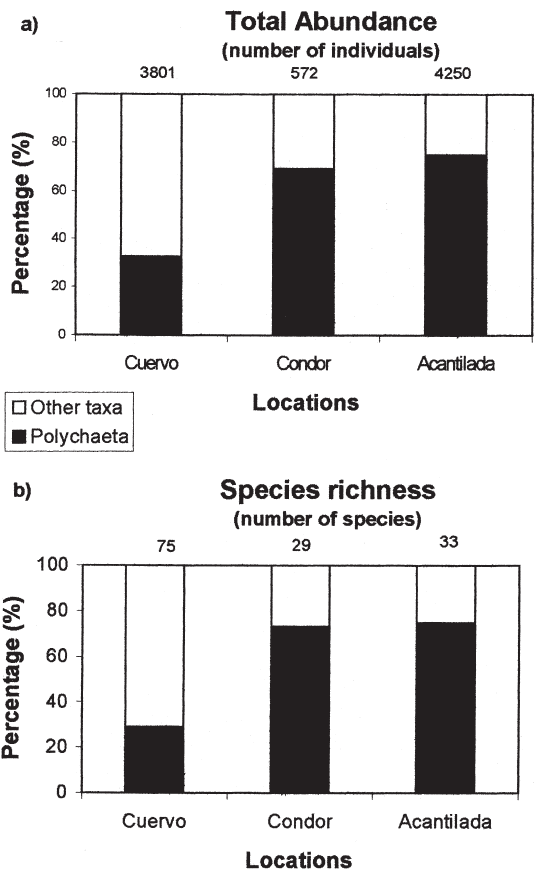
F IG . 3. – Comparison between Polychaeta and other invertebrate taxa collected in shallow, subtidal macrozoobenthos communities from three localities in Aysen Fjord, Chile. Sampling carried out September 21 to 26, 1995. The numbers over each bar represent the total number of individuals or species found at each study site: a ) total abundance, b) number of